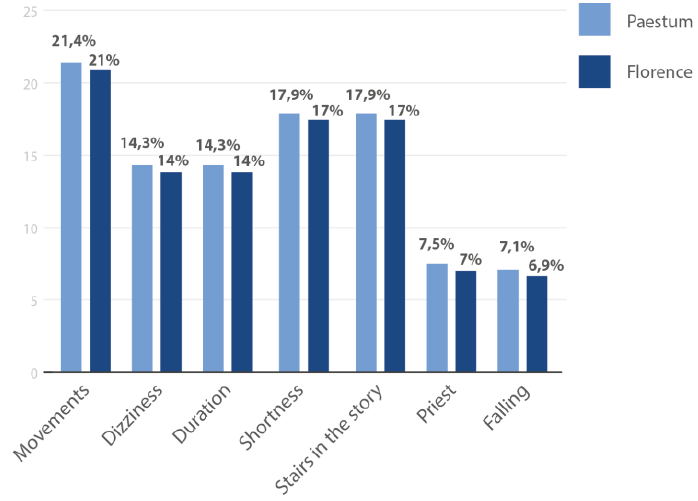
Figure 19. Preferences out of 70 + 75 responses to the question “ What did you dislike about this experience